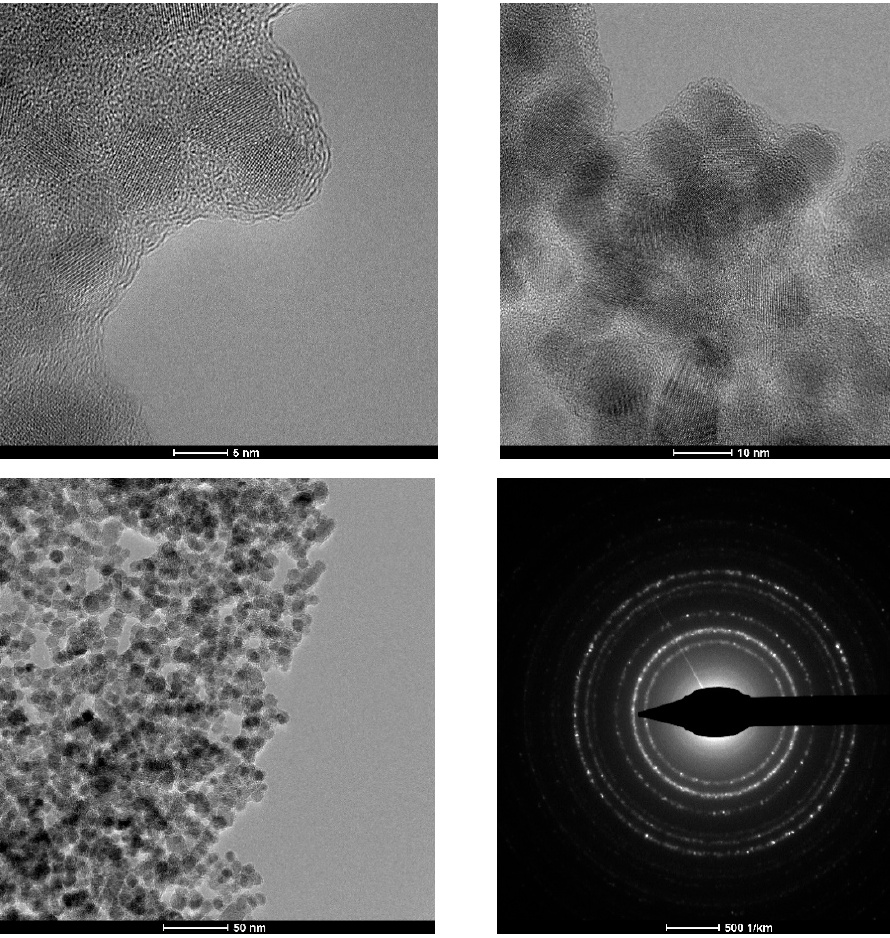
Figure 6. TEM and SAED images for MW-NPS-2 .